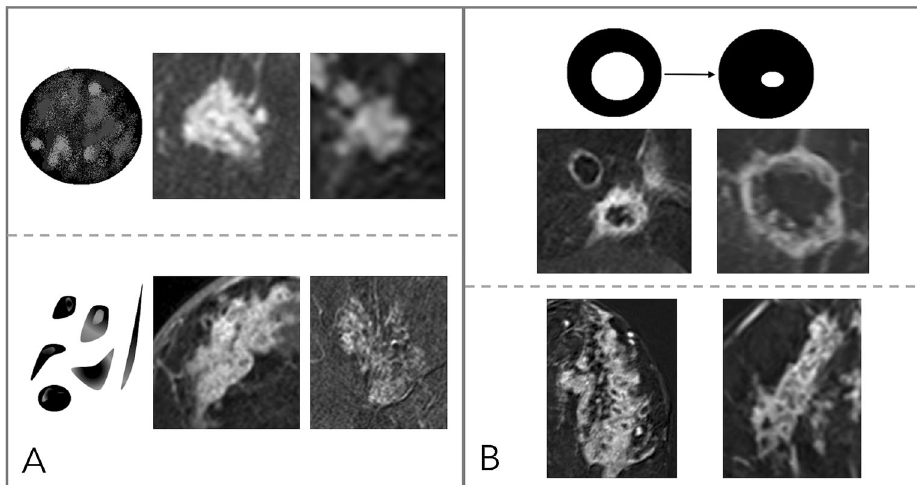
Fig. 5 Diagnostic criteria: suspicious internal enhancement patterns. Heterogeneous enhancement may be associated with breast cancer and applies to mass and non-mass lesions ( A, upper and lower row, respectively). Specific for malignancy is a centripetal or rim-like enhancement (B). In particular, a broad heterogeneous rim, regularly associated with a delayed enhancement of the central lesion parts, is highly suggestive of breast cancer (B, upper row). However, a thin,